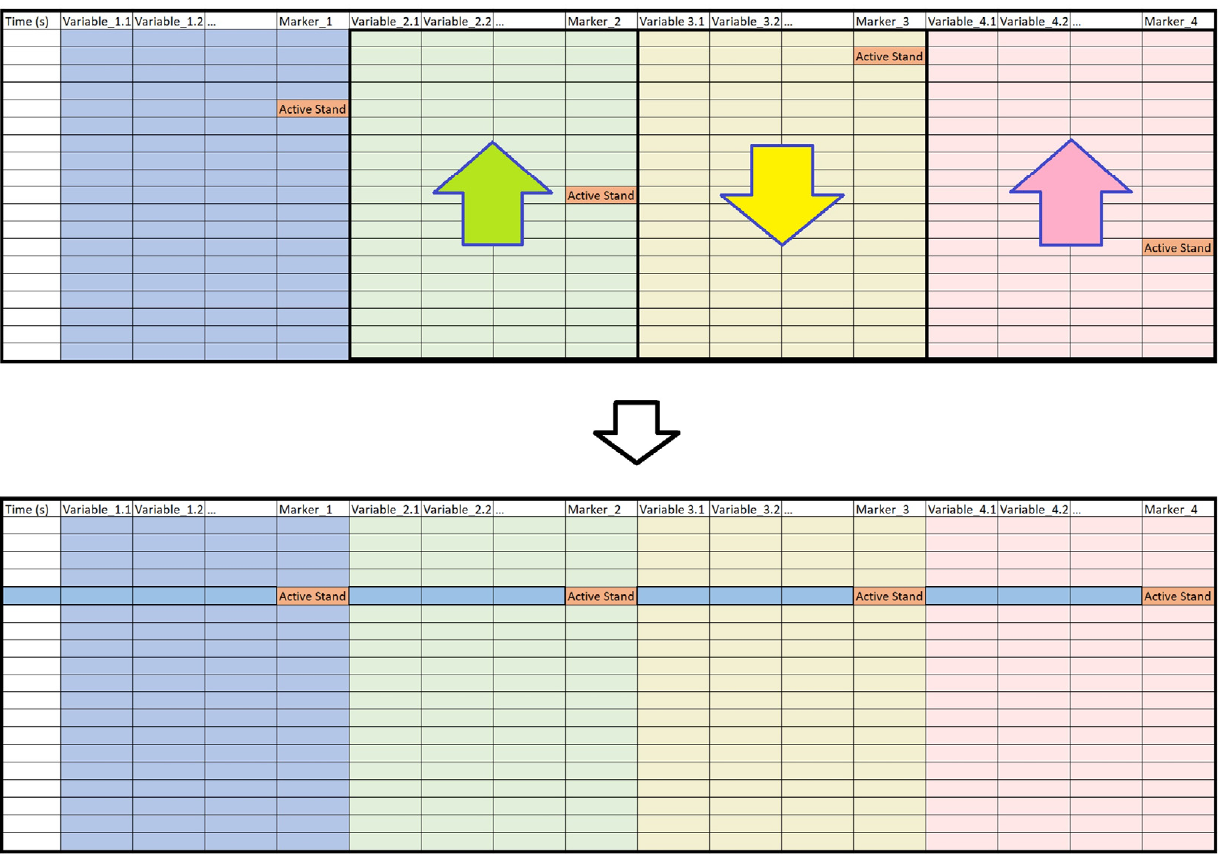
Figure 3. Illustration of the data syncing technique used in this study. A data frame that is merged from four separate time series data frames is shown on the top. There is an event marker variable “Active Stand” in each of the four constituent data frames, the time of which is located at different observations. The data frame is synced by shifting the variables in each of the constituent data frames, so that all the event marker variables are aligned, as shown at the bottom.